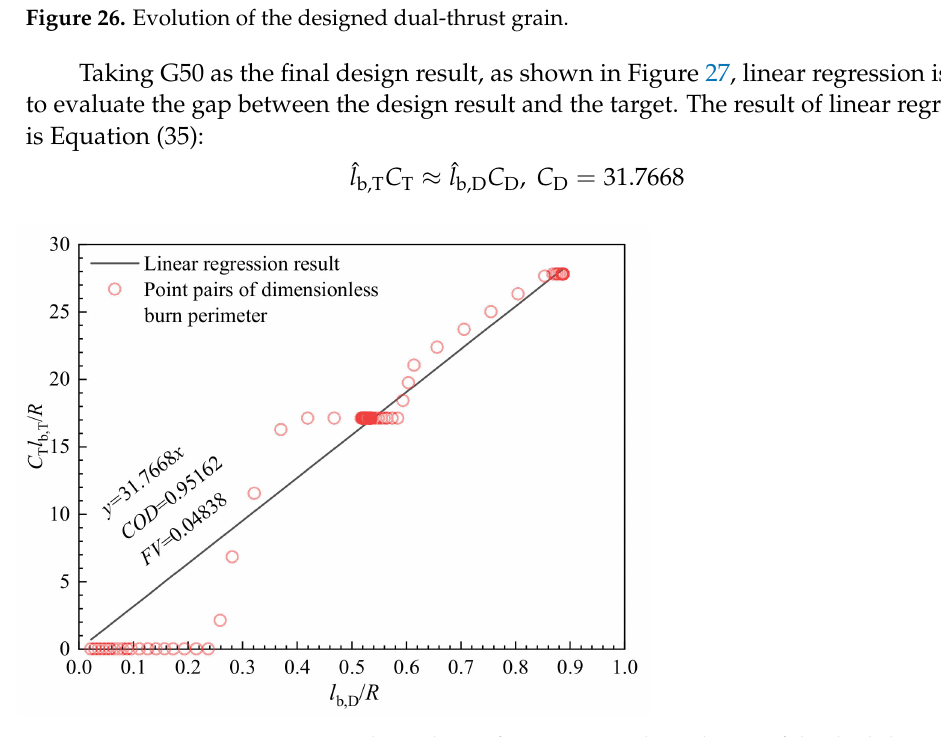
Figure 27. Linear regression to evaluate the performance-matching degree of the dual-thrust